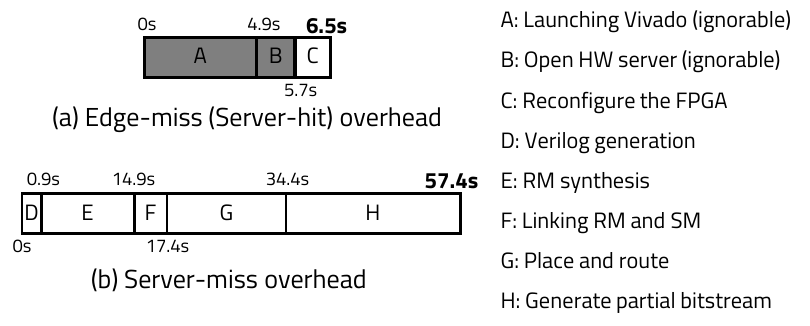
Figure 16. Overhead composition for each case.